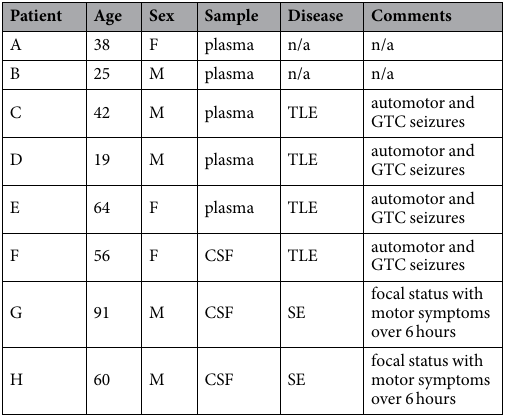
Table 1. Summary of patient and healthy volunteer data. Key: F, female; M, male; CSF, cerebrospinal fluid; TLE, temporal lobe epilepsy; SE, status epilepticus; GTC, generalised tonic